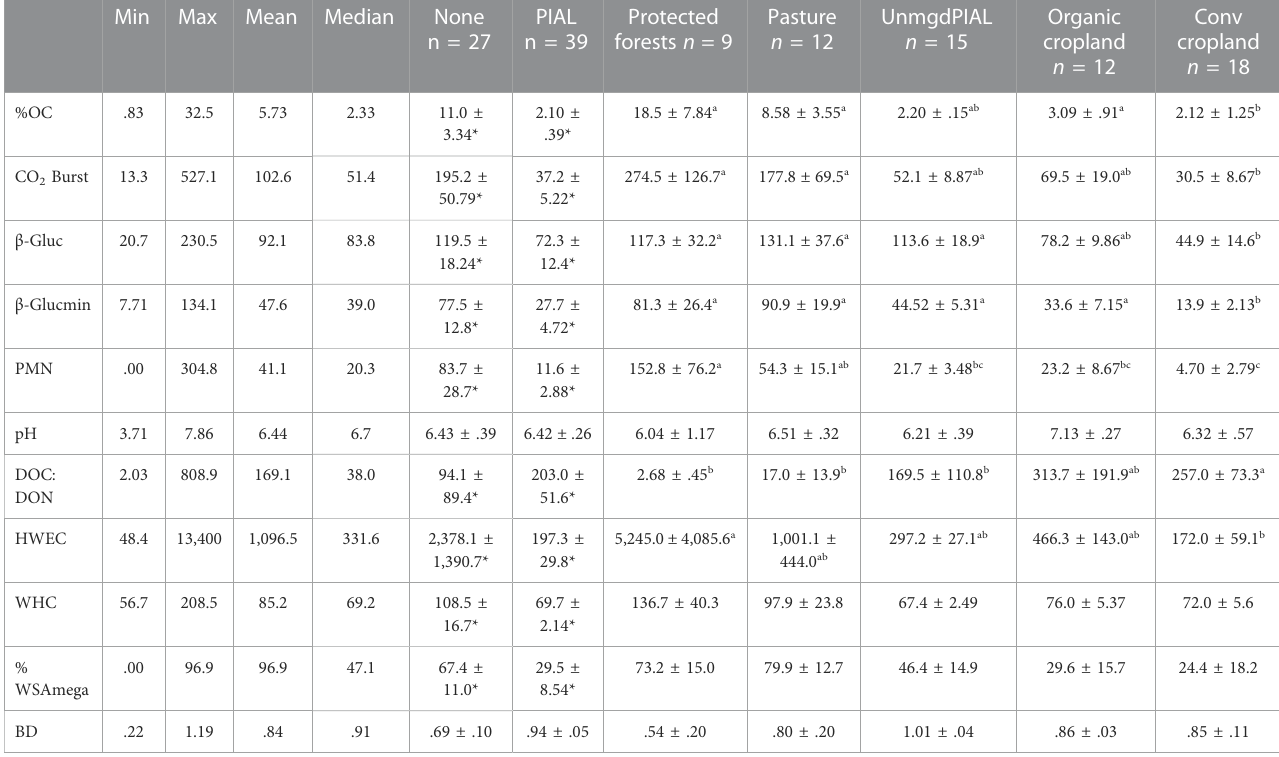
TABLE 4 Data summary for the proposed key indicators of health for subtropical/tropical and volcanic soils. Signi fi cant differences are indicated by * for the past land use (PIAL versus None) comparison and letters for the current land use comparisons (Tukey-adjusted comparison, p -value < .05).